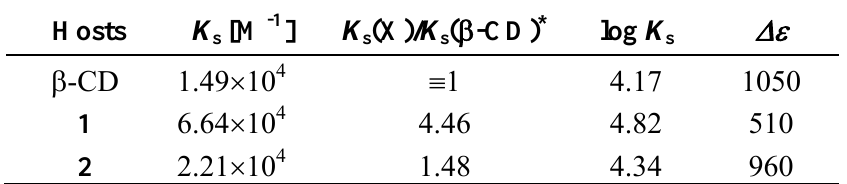
) for 1:1 inclusion complexation of 3 with β -CD, 1 s